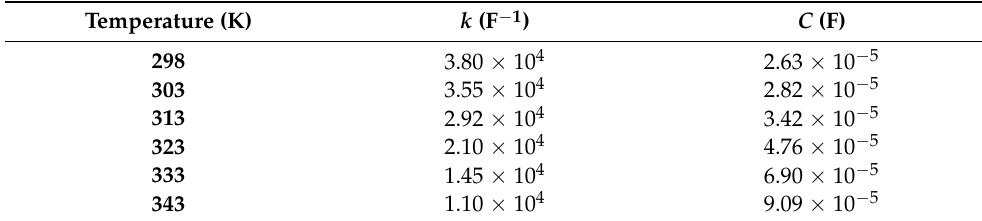
Table 6. High temperature circuit elements for the SL4